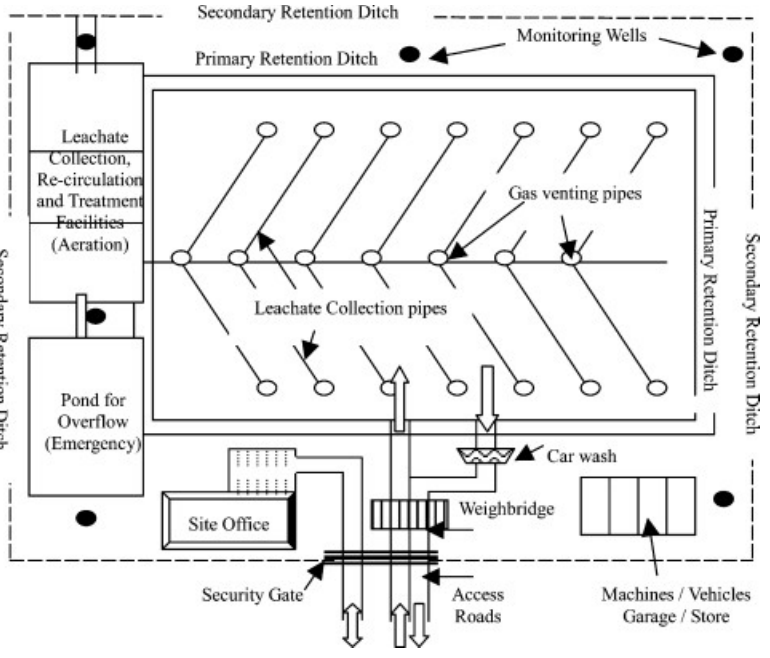
Figure 2. An illustration of a landfill that uses a semi ‐ aerobic process [12].